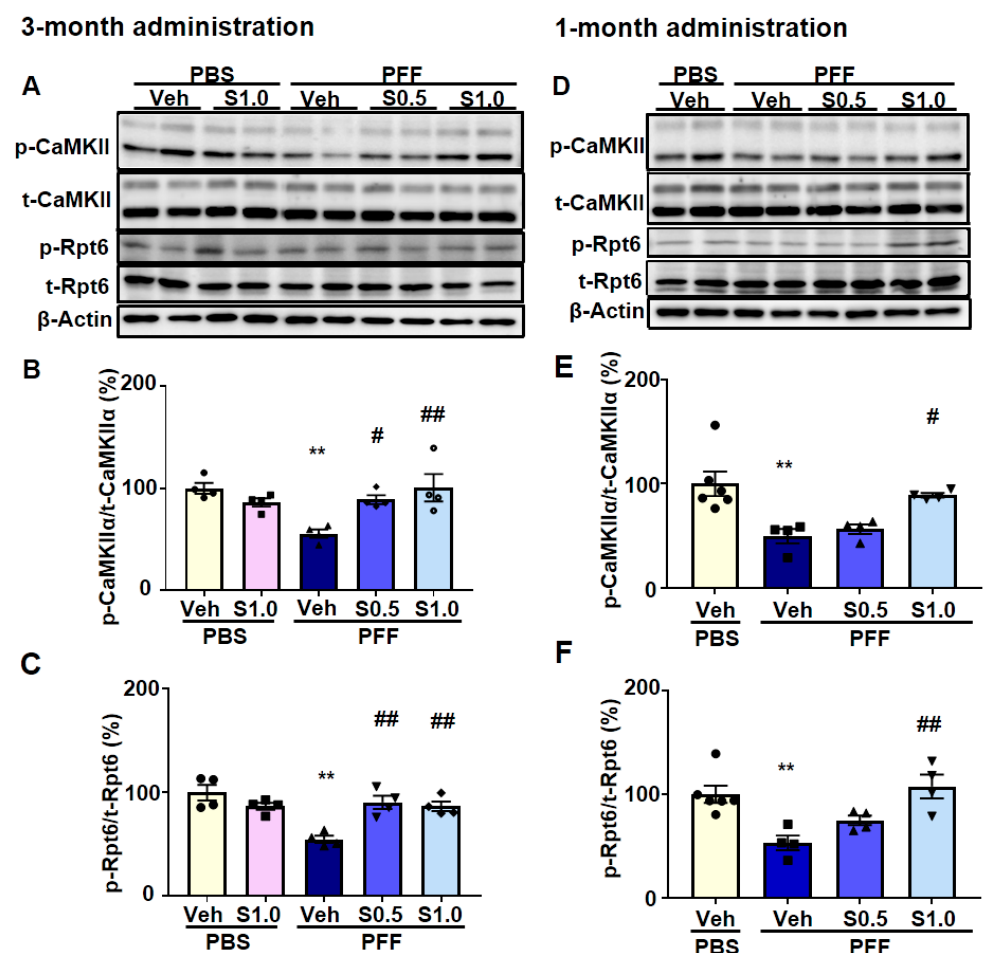
Figure 6. SAK3 administration improves CaMKII-Rpt6 signaling in α -Syn PFF-injected mice. ( A , D ) Representative images of western blot membranes containing cortical protein, probed with antibodies against autophosphorylated CaMKII (T286), CaMKII, phosphorylated Rpt6 (S120), Rpt6, and β -actin. Quantitative analyses of ( B , E ) autophosphorylated CaMKII (T286) and ( C , F ) phosphorylated Rpt6 (S120), during the 3-month SAK3 treatment schedule ( n = 4 per group) and the 1-month SAK3 treatment schedule ( n = 4–6 per group). Error bars represent SEM. ** p < 0.01 vs. vehicle-treated PBS-injected mice; # p < 0.05, ## p < 0.01 vs. vehicle-treated α -Syn PFF-injected mice. Abbreviations: Veh = vehicle; S = SAK3.